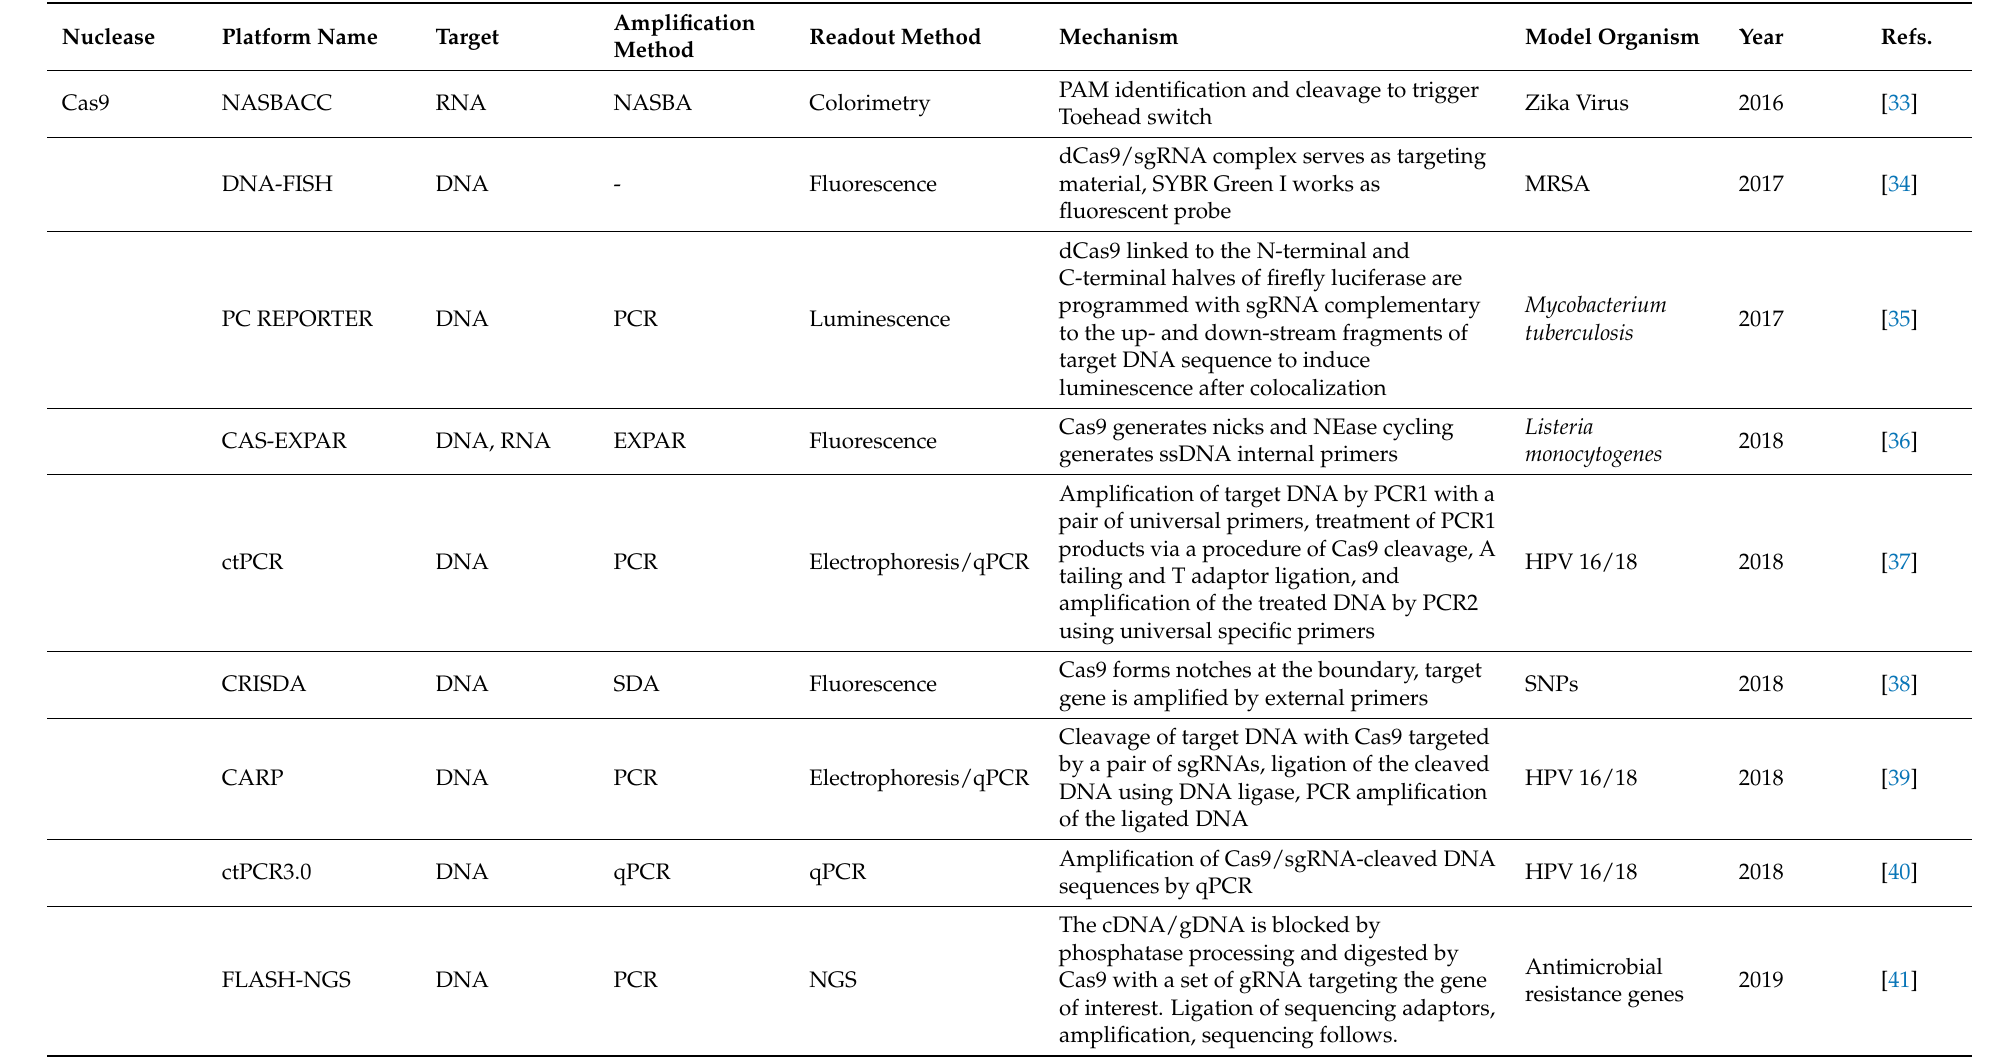
Table 1. Summary of reported CRISPR/Cas-based diagnostic platforms and their detection